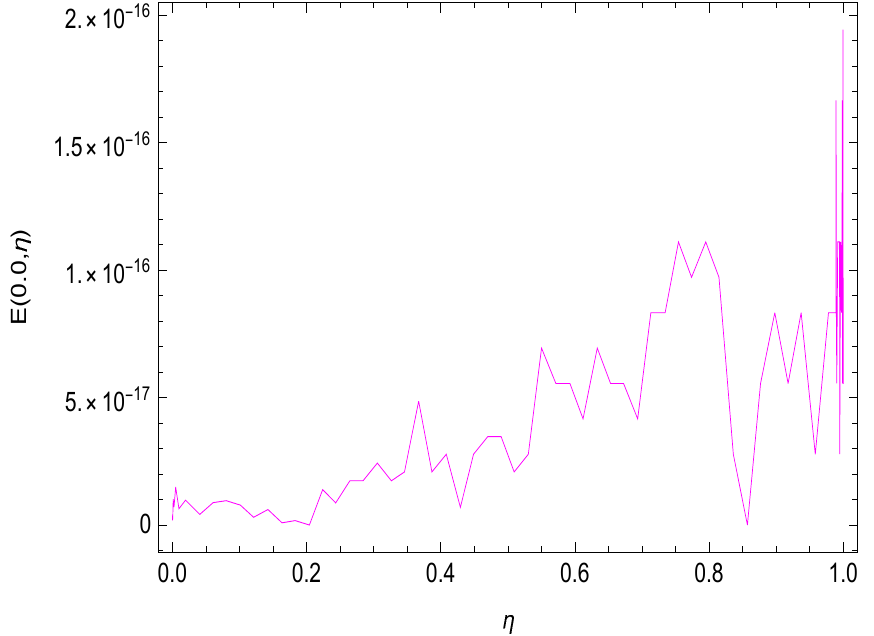
Figure 10. ς -absolute errors of the problem (18), where ε = 1.5, ν = 0.5 and N = M = K =